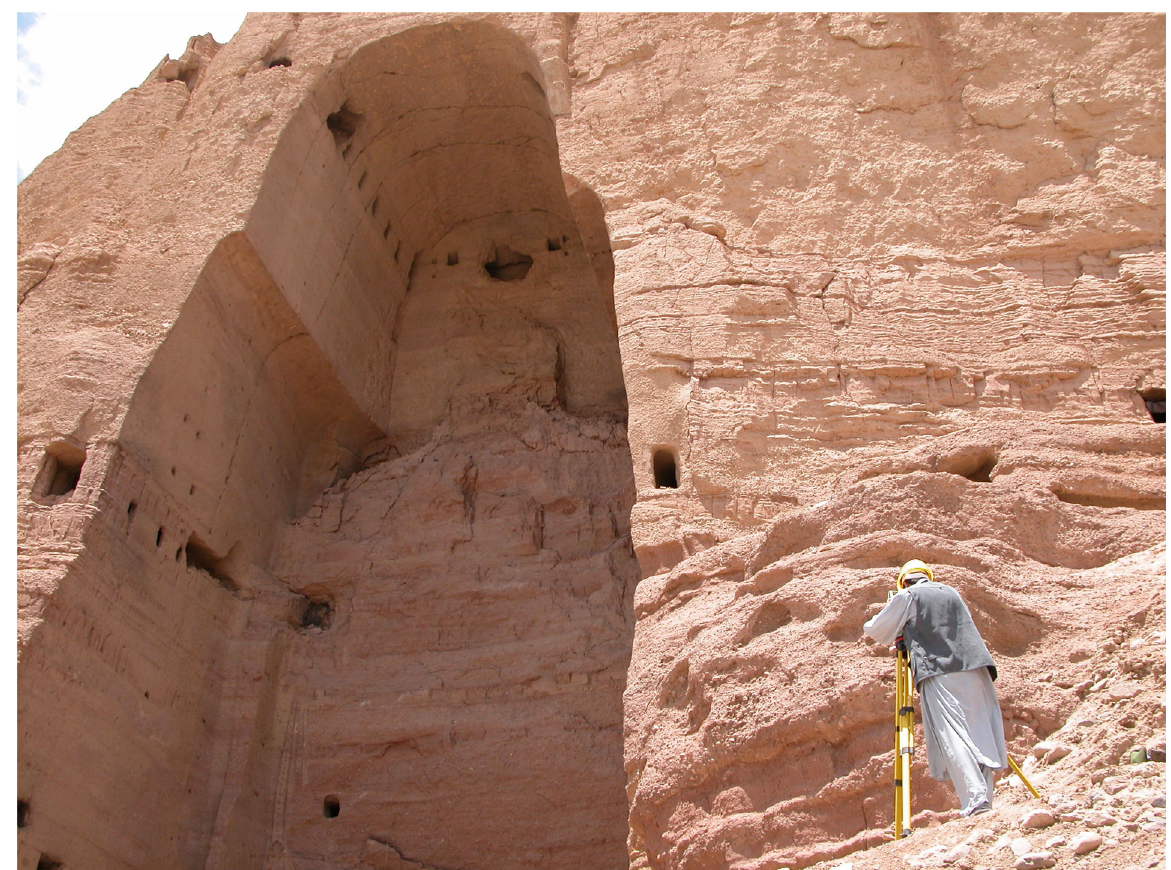
Fig. 6 Using a Total Station to record the deterioration of the Bamiyan Valley (2003) (Source: the authors)